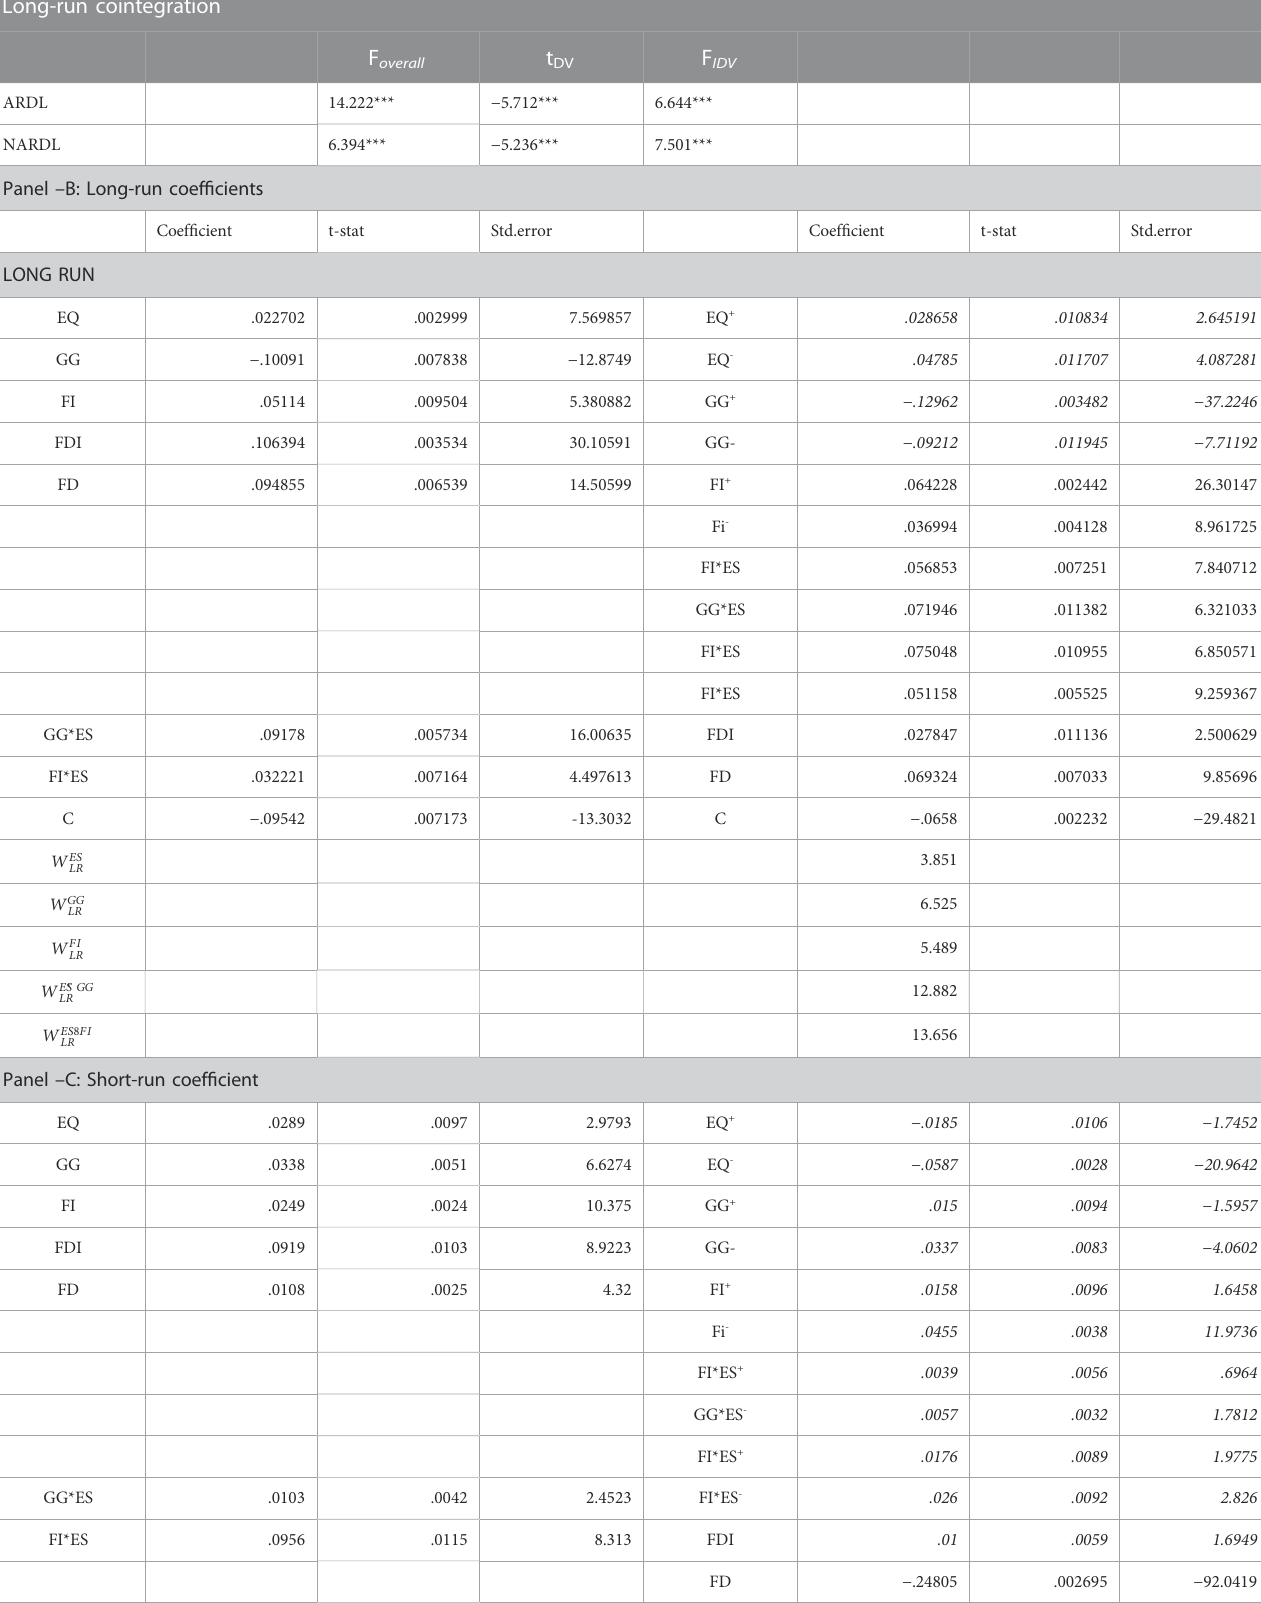
TABLE 10 Results of Mediation